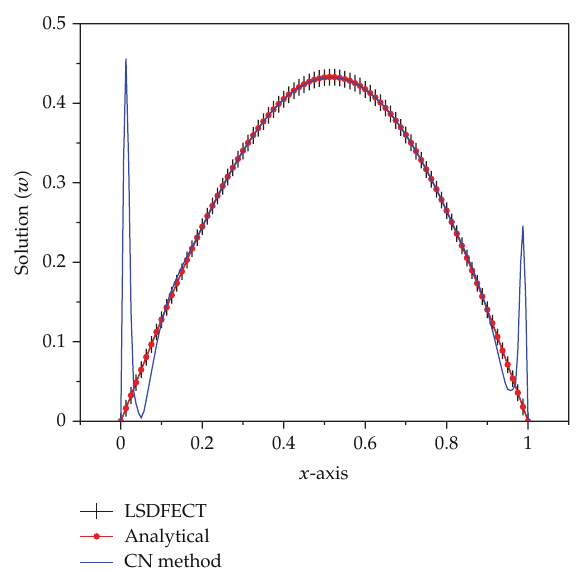
Figure 3: Comparison of the numerical solution by our method (cid:2) LSDFECT (cid:3) , CN method, and exact solution of Problem 3 at di ff erent space points for N (cid:8) 80, ν d (cid:8) 2, and k (cid:8) 0 . 01 at T (cid:8) 0 . 1.